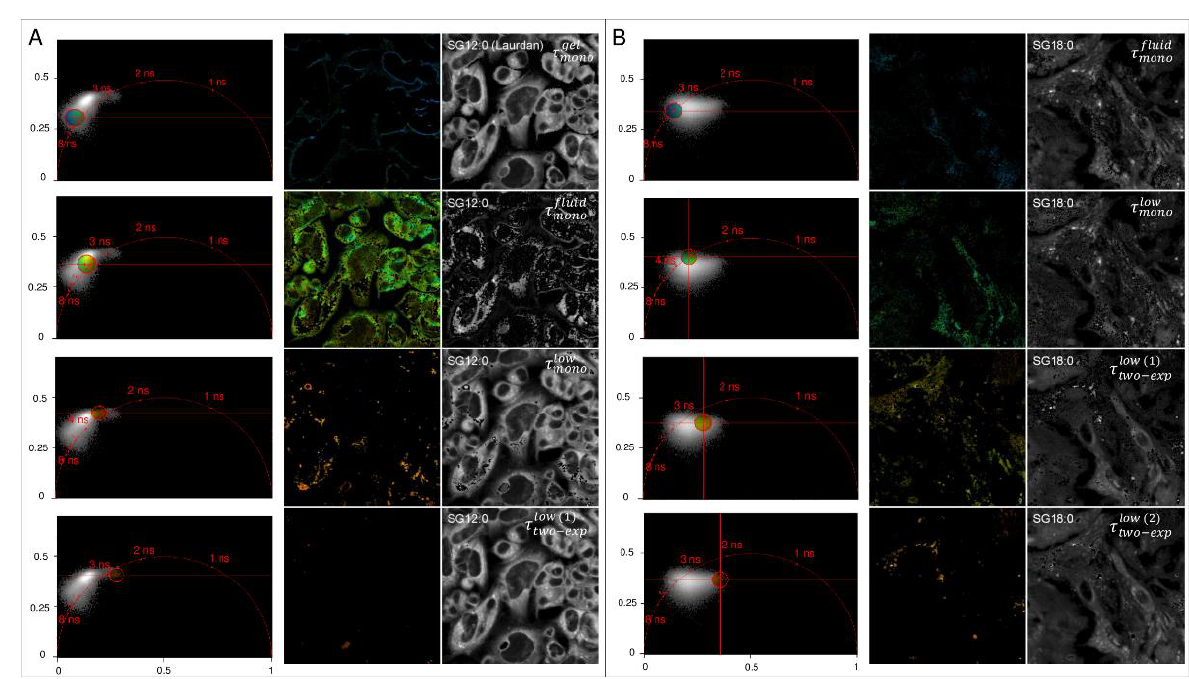
Figure 3. Phasor-driven segmentation of fatty-acid derivatives for SG12:0 ( A ) and SG16:0 ( B ). In the first column the phasor plot of a representative SG12:0 image is reported. On the phasor plot, selected pixels in a circular Region-of-Interest (ROI) are remapped to the original fluorescence image. In the second column the original image without the segmented phasor pixel is reported, and in the third column the phasor-driven segmentation is reported. In SG12:0 the gel phase ( 𝜏 𝑚𝑜𝑛𝑜𝑔𝑒𝑙 ) is mainly localized on the PM, while in the SG18:0 the probe failed to compartmentalize on PM, and the gel phase is almost no detectable. Environments characterized by intermediate ( 𝜏 𝑚𝑜𝑛𝑜𝑓𝑙𝑢𝑖𝑑 ) and fluid phase ( 𝜏 𝑚𝑜𝑛𝑜𝑙𝑜𝑤 ) are instead visible with both probes.